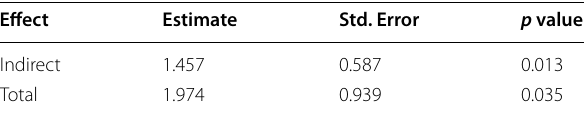
Table 5 Structural model effects Effect